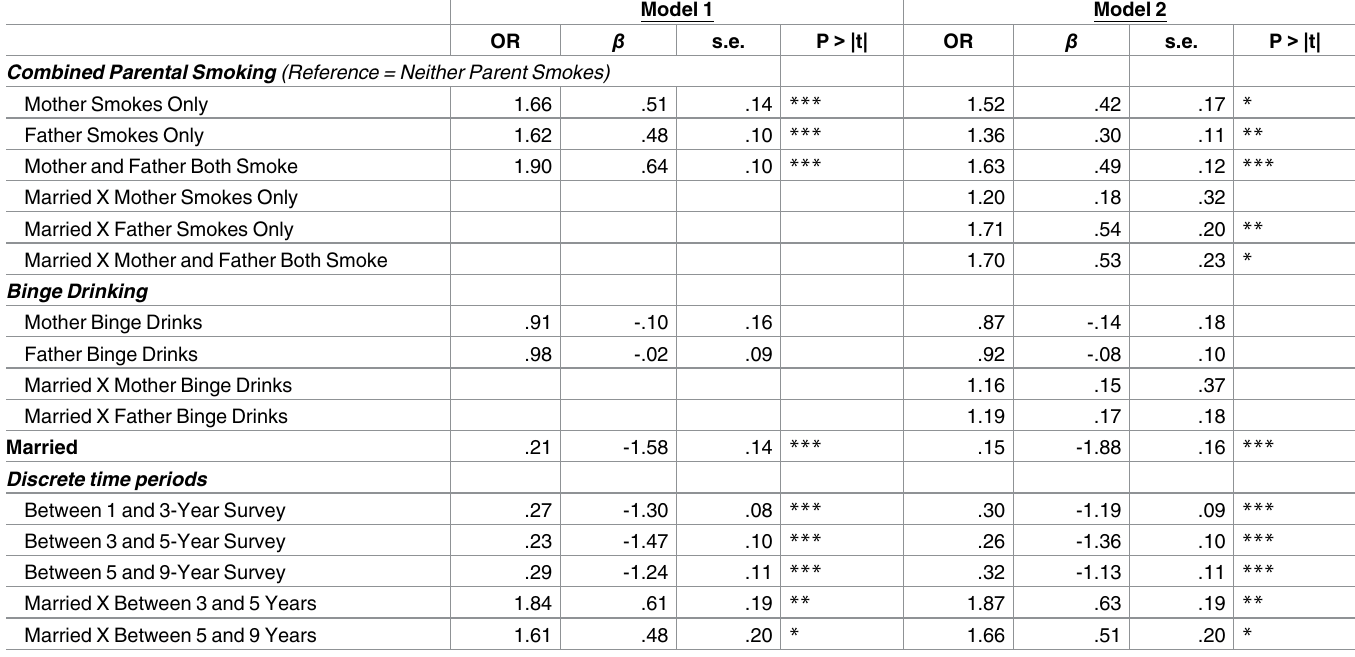
Table 2. Results from discrete time hazard models predicting union dissolution by parental health behaviors (OR = odds ratio, β = coefficient, s.e. = standard